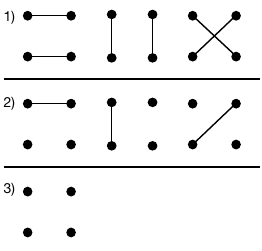
Figure 1 . Parity even index structures of 4-photon